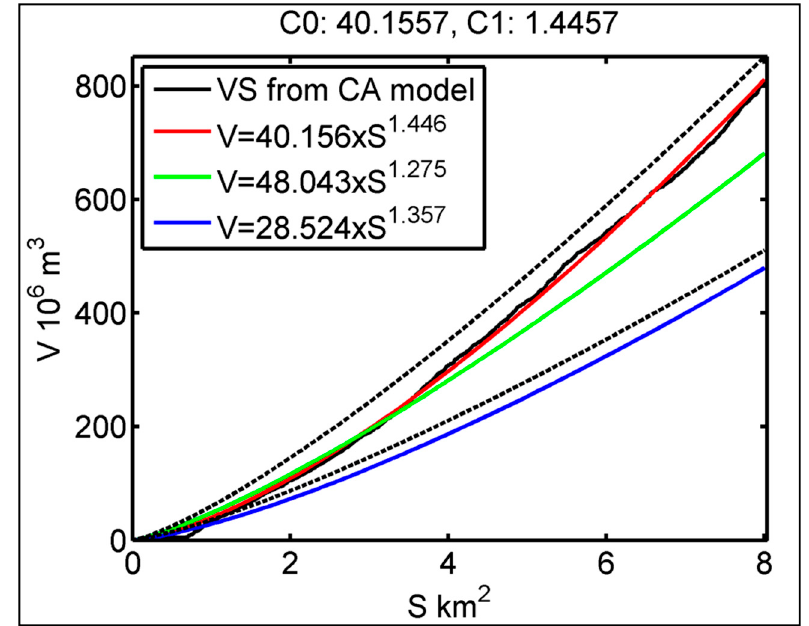
Figure 9. The volume and surface area (V-S) scaling of YAN from the cellular automata (CA) model and its fitting with scaling factors (red) for the comparison with the V-S scaling calculated from six individual glaciers [65], including YAN (green), and the V-S scaling from Chen and Ohmura, 1990 (blue). The black dotted line represents the 25% error estimation from the V-S scaling from six individual glaciers in the Cordillera Blanca.